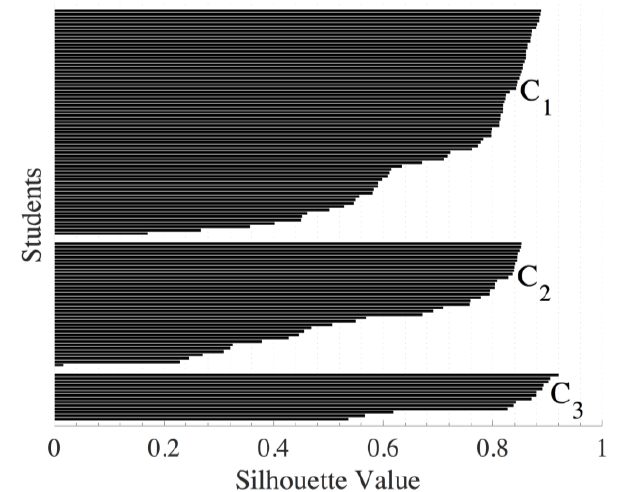
Figure 1 Silhouette values for the whole sample. Horizontal and vertical axes represent students and silhouette values, respectively. C 1 , C 2 and C 3 represent the three centroids of the three clusters formed. The silhouette average value is